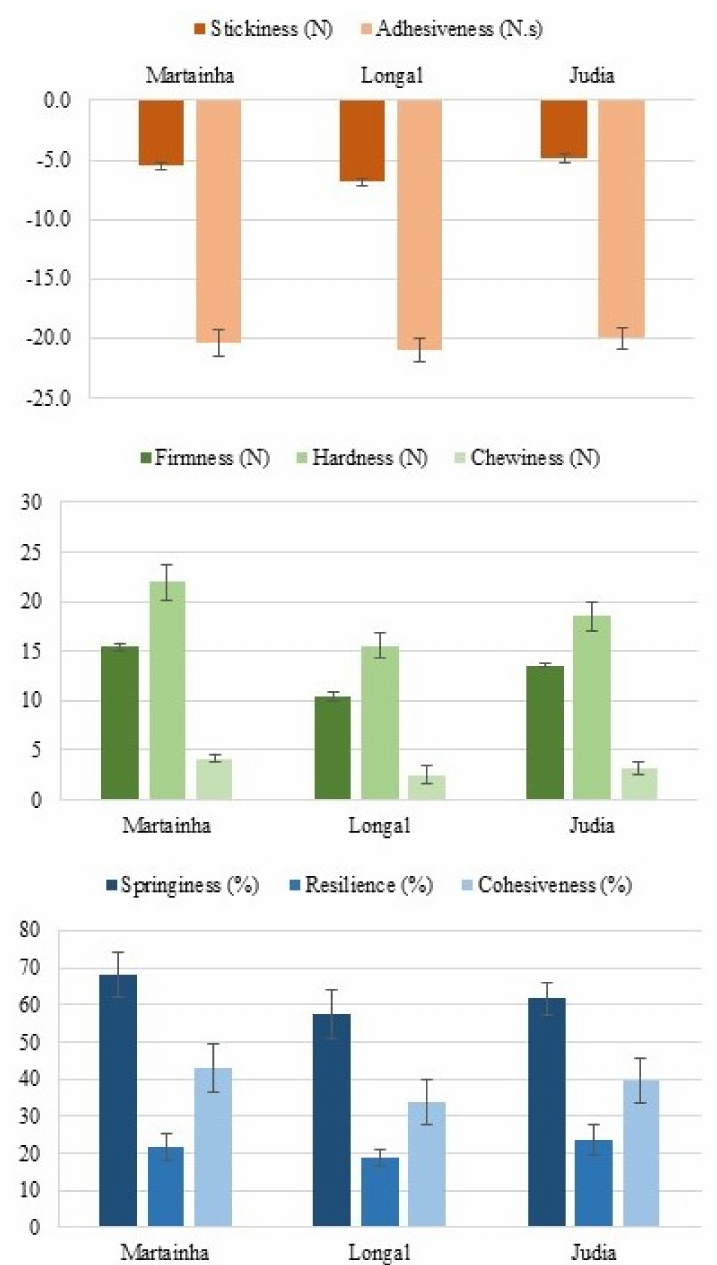
Figure 9. Textural parameters of the candied